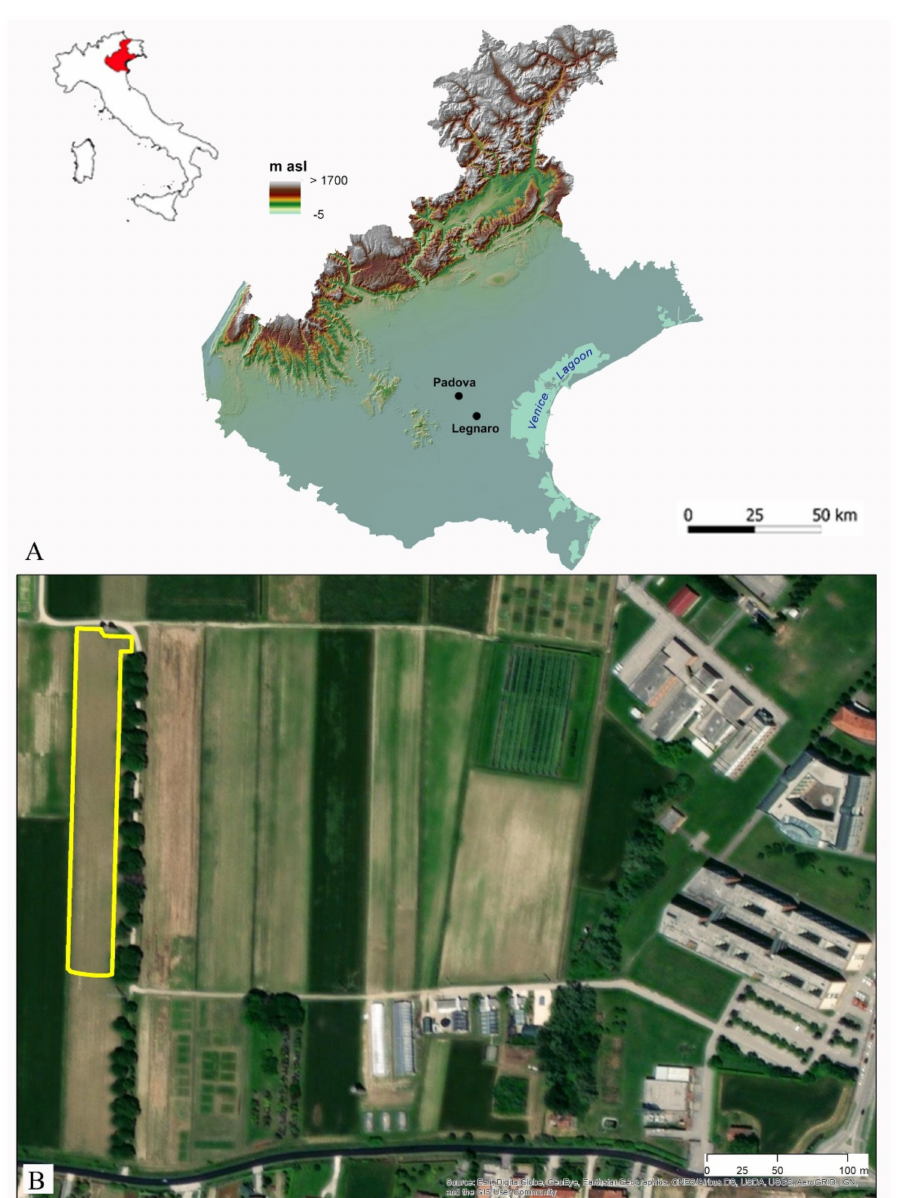
Figure 1. ( A ) Veneto Region: Digital Elevation Model and localization of the study site; ( B ) study site at the Experimental farm “L. Toniolo” (University of Padova, NE